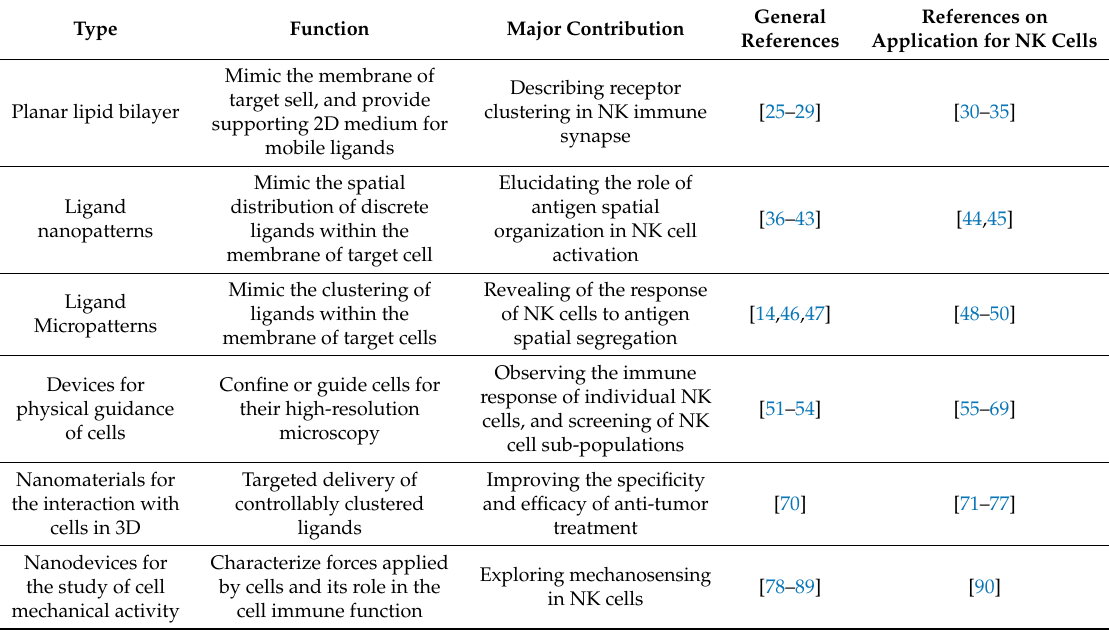
Table 1. Advanced materials and devices for the study and regulation of NK